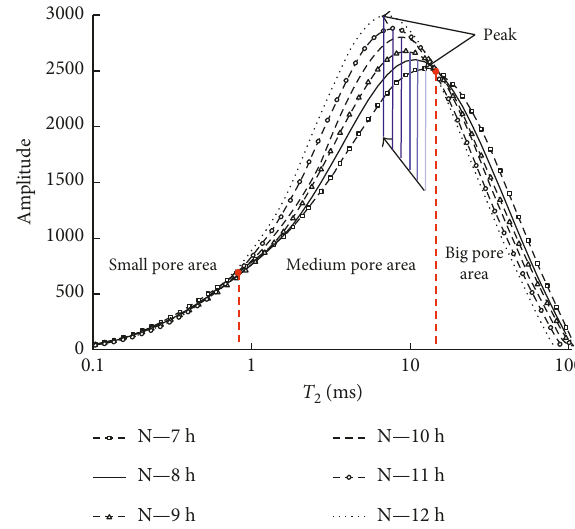
Figure 9: (NH 4 ) 2 SO 4 leaching (the third